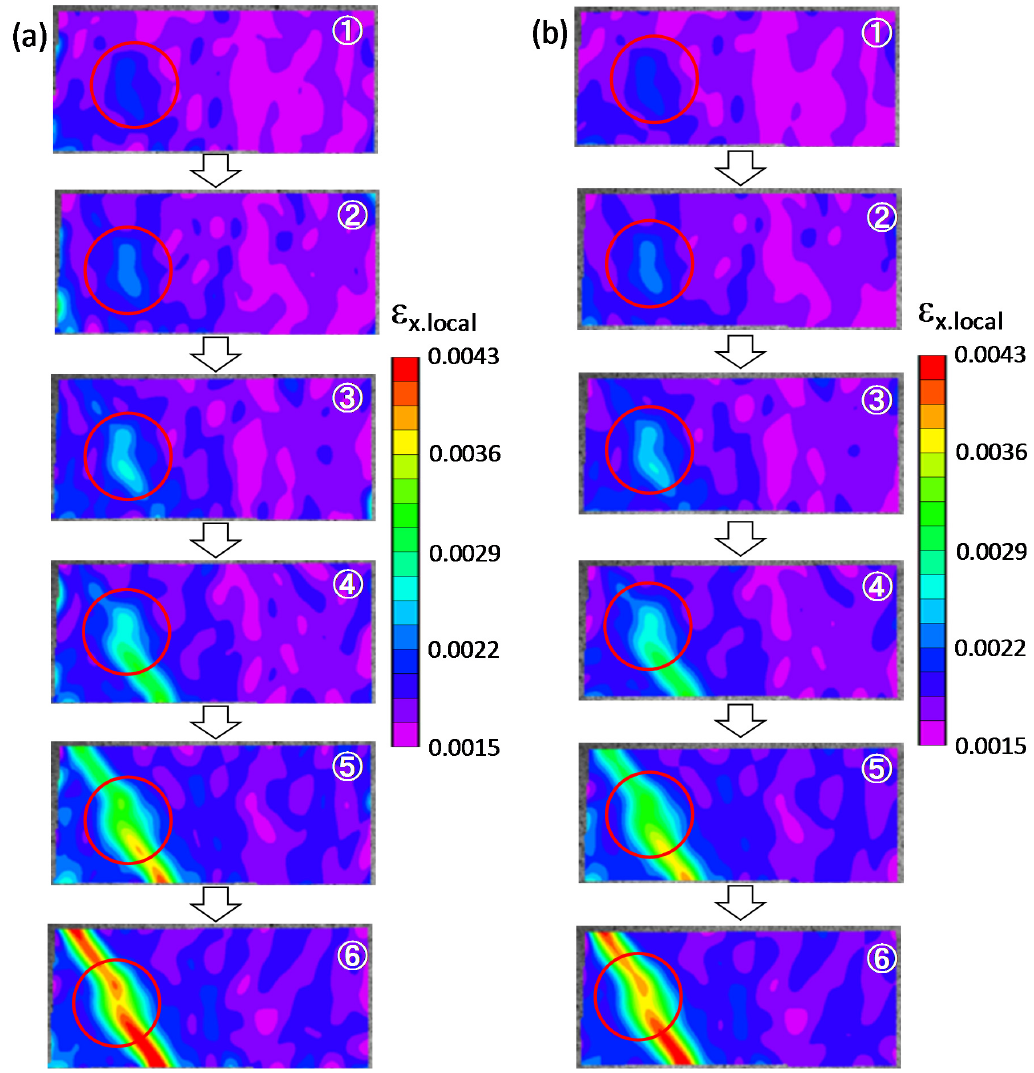
Figure 6. Evolution of the strain field. DIC parameters: ( a ) subset size, 21 pixels × 21 pixels (579 µ m × 579 µ m), step, 5 pixels (138 µ m), and ( b ) subset size, 41 pixels × 41 pixels (1.13 mm × 1.13 mm), step 5 pixels (138 µ m). Each image corresponds to the image in Figure 5.